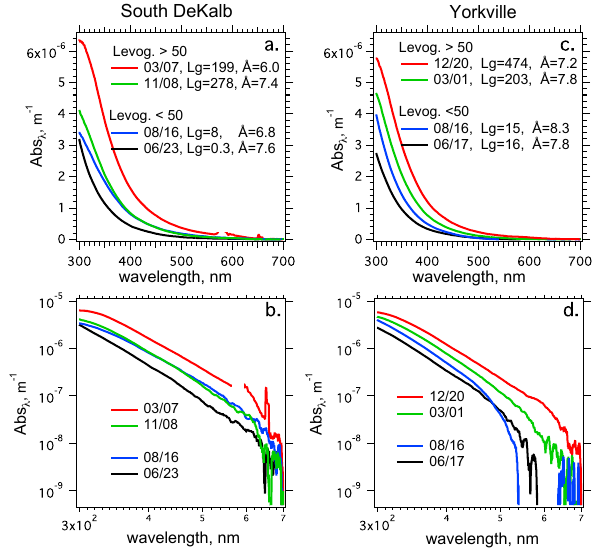
Fig. 4. Examples of absorption spectra from FRM filters col- lected at a representative urban, (South Dekalb, (a) and (b) ) and rural (Yorkville, (c) and (d) ) site for biomass burning (lev- oglucosan > 50ngm − 3 ) and non-biomass burning (levoglucosan < 50ngm − 3 ) periods. Sample date (MM/DD) of 2007, levoglu- cosan concentraction (ng m − 3 ), and the ˚Angstrom exponents ( ˚A ) are given. These sampling days are also identified in Fig.